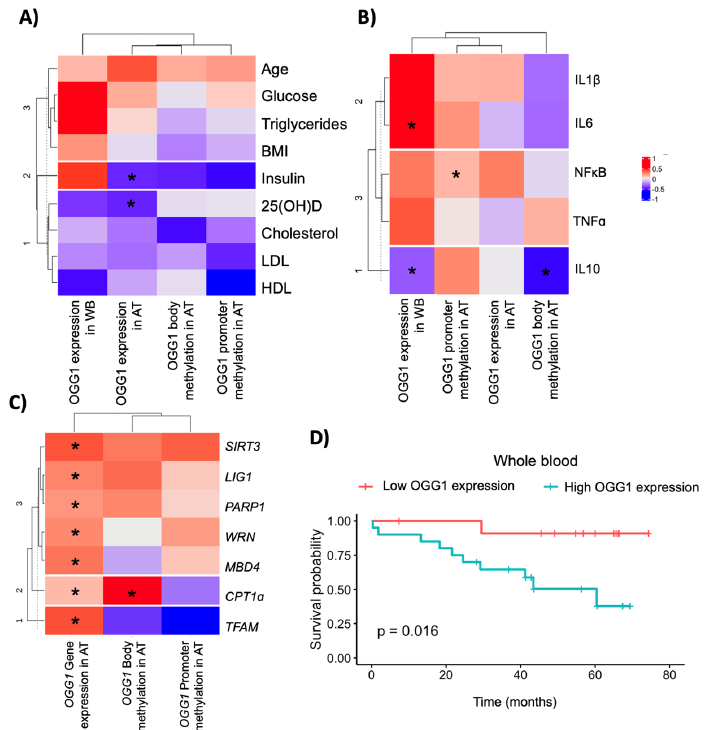
Figure 2. OGG1 expression in adipose tissue and metabolic and DNA repair genes: ( A ) Heatmap of Pearson’s correlation between OGG1 expression and methylation, and anthropometric and biochemical variables in all participants. ( B ) Heatmap of Pearson’s correlation between OGG1 expression and methylation and gene expression of inflammatory genes in visceral adipose tissue in all participants. ( C ) Heatmap of Pearson’s correlation between OGG1 expression and methylation and gene expression of DNA repair genes in visceral adipose tissue from healthy participants ( D ) Kaplan–Meier estimates for overall survival according to gene expression of OGG1 (low vs. high under the median value) in whole blood. The asterisks indicate a significant correlation between variables according to Pearson’s correlation test (* p < 0.05). Abbreviations: AT: adipose tissue; WB: whole